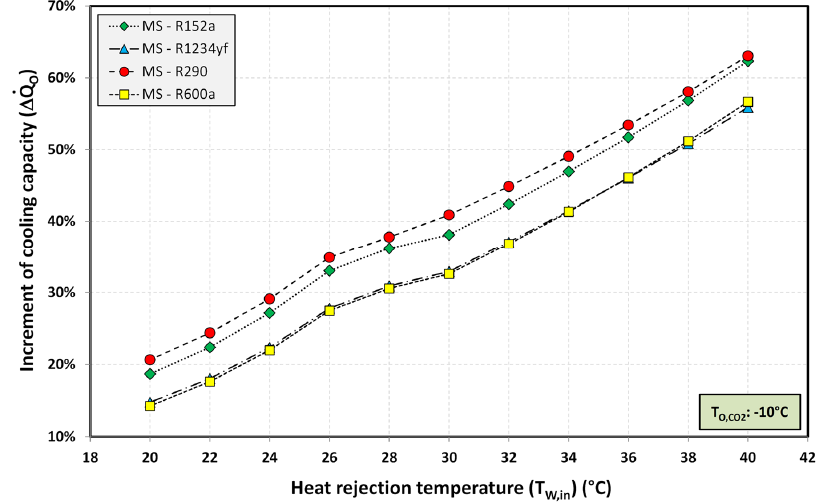
Figure 11. Increment of cooling capacity at the optimal operating conditions vs. heat rejection pressure.